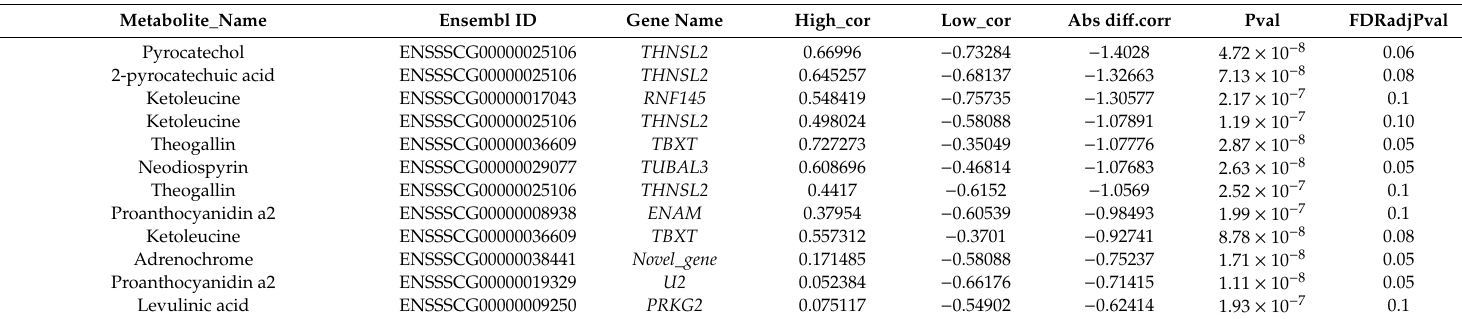
Table 2. Gene-metabolite interaction pairs from IntLIM for the FE-specific